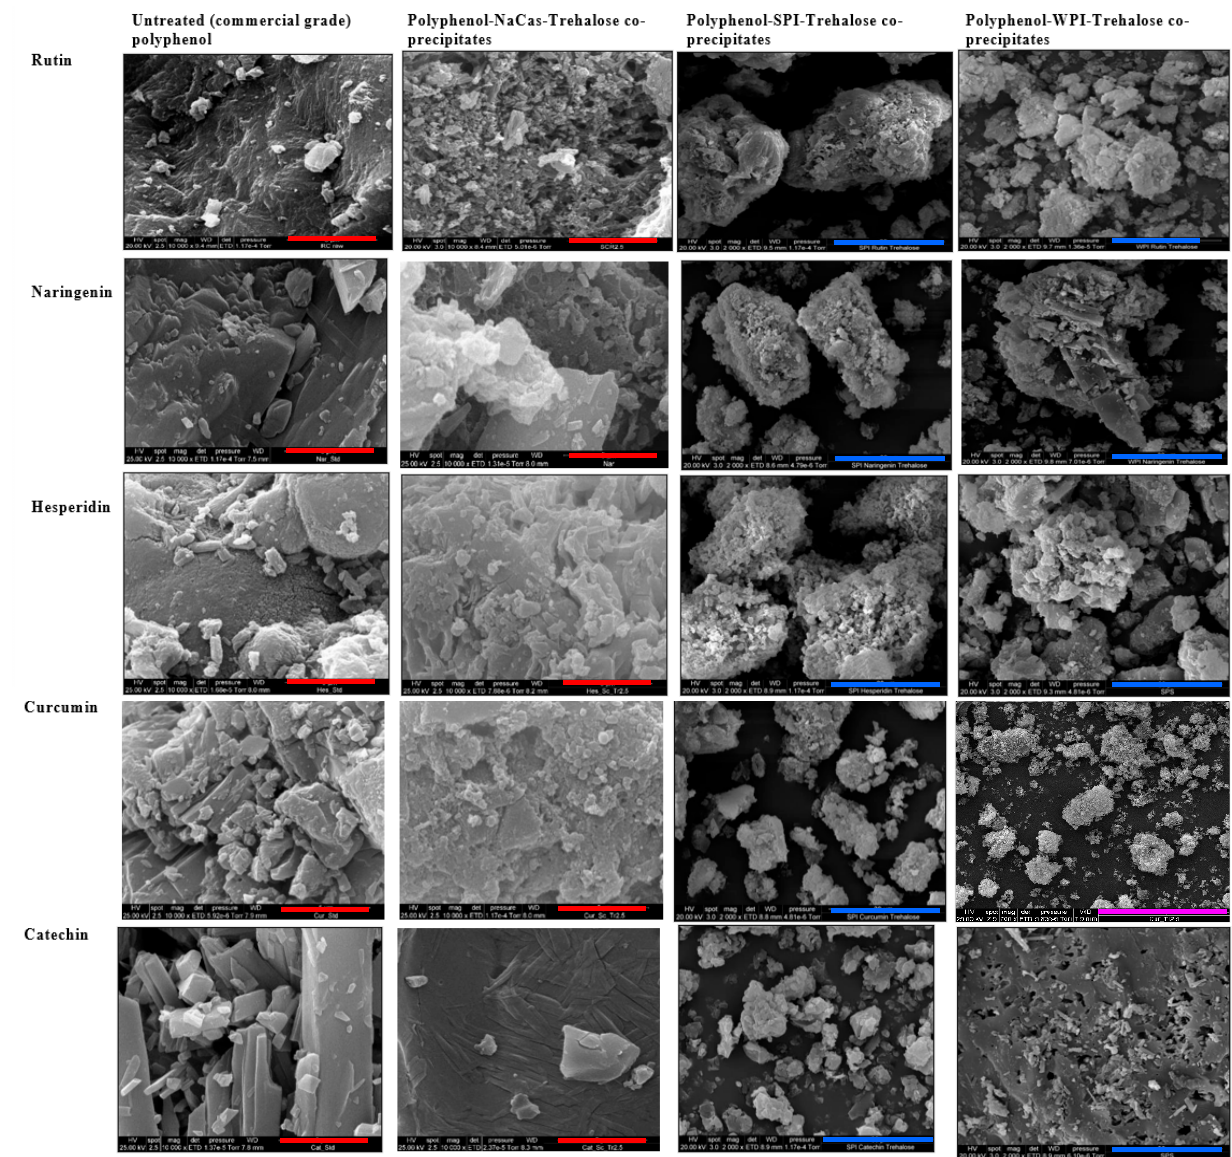
Figure 2. Scanning electron micrographs of the powders of untreated polyphenols and the co- precipitates of each polyphenol with different proteins in the presence of trehalose. The scale bars for each micrograph are colored red for 5 µm, blue for 30 µm and magenta for 100 µm. NaCas: sodium caseinate, SPI: soy protein isolate, and WPI: whey protein isolate.